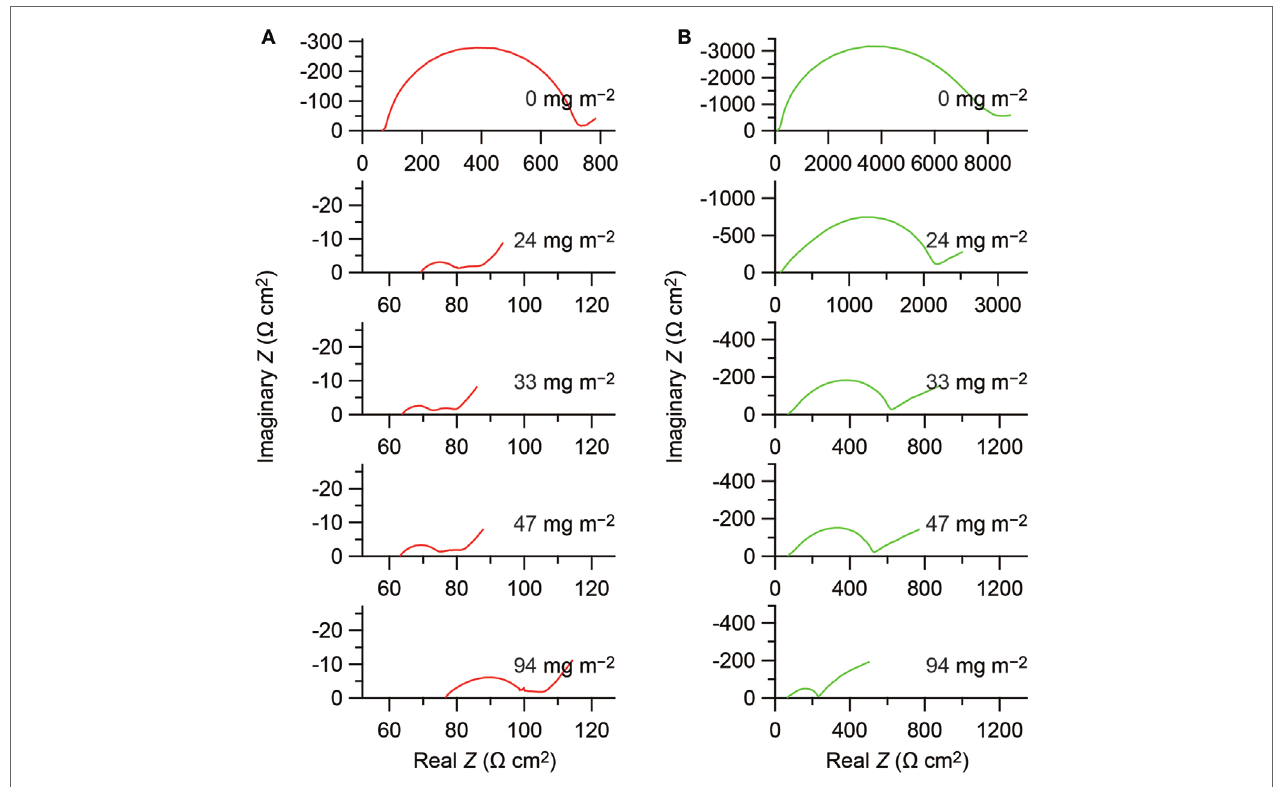
FigUre 1 | nyquist plots obtained from the solid-state electrochemical cells with configuration of in–li x /li 1 − x coO 2 (a) and in–li x /li 1 − x Mn 2 O 4 (B) . Horizontal and vertical axes indicate real and imaginary parts of the complex impedance based on the projection areas of the cathodes, respectively. The amounts of the LiNbO 3 coating on the active materials are indicated on the basis of the BET surface areas of the active materials in the figures. Impedance date reported in Ohta et al. (2007) and Takada et al. (2012) are replotted in this figure, copyright © 2007 and 2012, with permission from